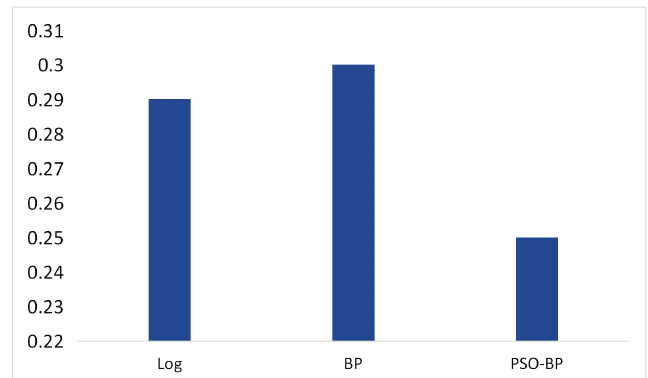
Figure 10. The normalized sum of squared errors (SSE) of the RSSI distance model fitted by the logarithmic distance loss model, BPNN, and PSO-BPNN.